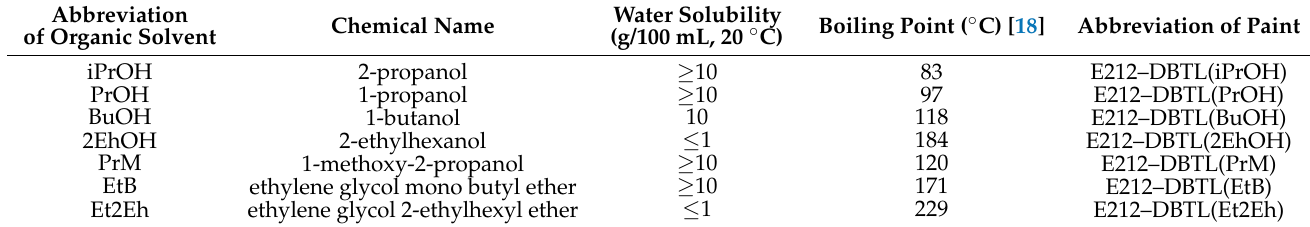
Table 1. Abbreviations for organic solvents and